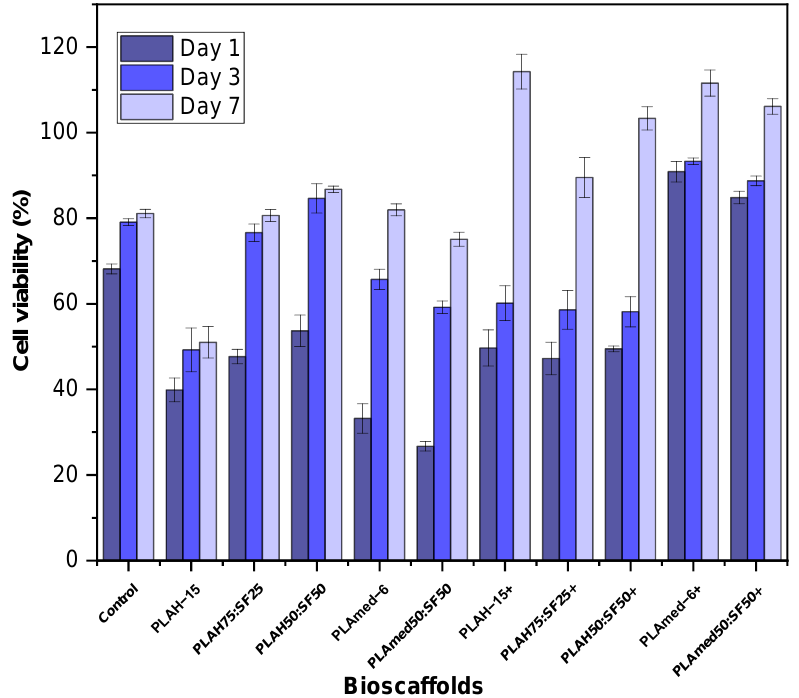
Figure 10. MTT assay for human chondrocyte cells viability on electrospun scaffolds after 1, 3, and 7 days. The plus sign (+) represents ethanol treated scaffolds (group 1).